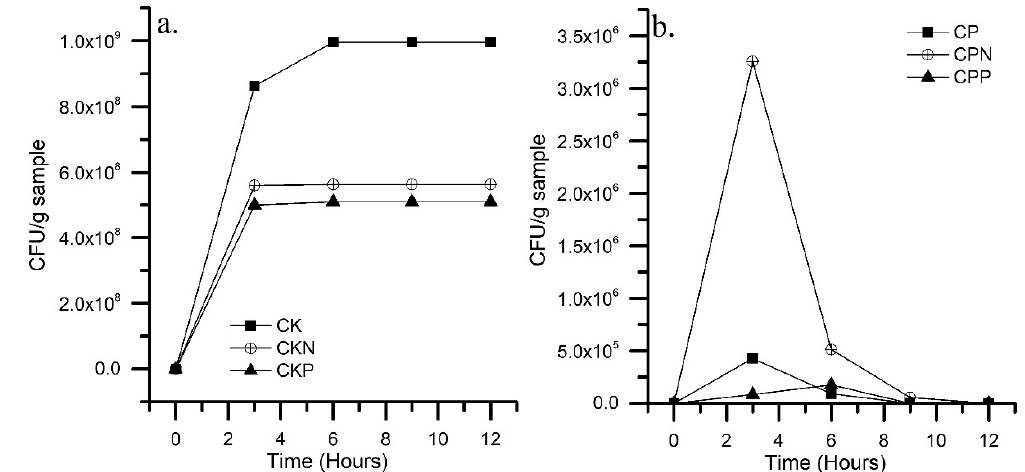
Figure 4. Immobilization kinetics of P. stutzeri on activated carbons prepared by chemical activation of olive stones with ( a ) potassium hydroxide (CK) and ( b ) phosphoric acid (CP); functionalized with melamine (CKN and CPN) and phosphoric acid (CKP and CPP).